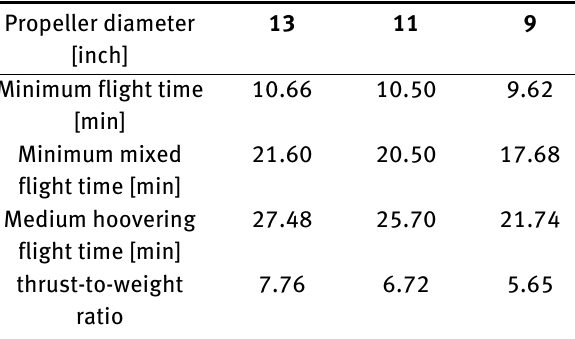
Table 4: Flight time and thrust-to-weight ratio in relation with the propeller